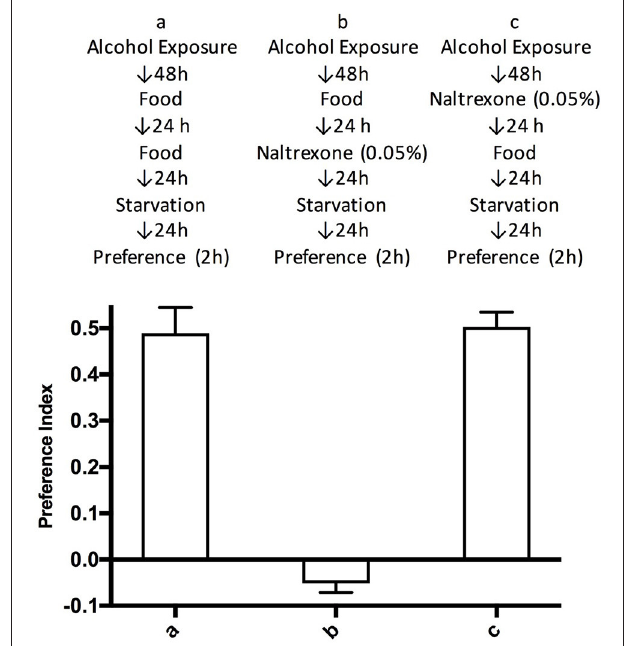
FIGURE 3 | Time duration of naltrexone effect. Flies were treated according to schemes a–c described in the top part of the figure. Preference indices were measured after 2h. Each bar represents three experiments with triplicate assays containing 9 flies each, n = 9. Error bars are SEM. One-way ANOVA with Bonferroni multiple comparison analysis showed a significant difference between group a and b, and b and c, p < 0.001, but not between a and c with p =